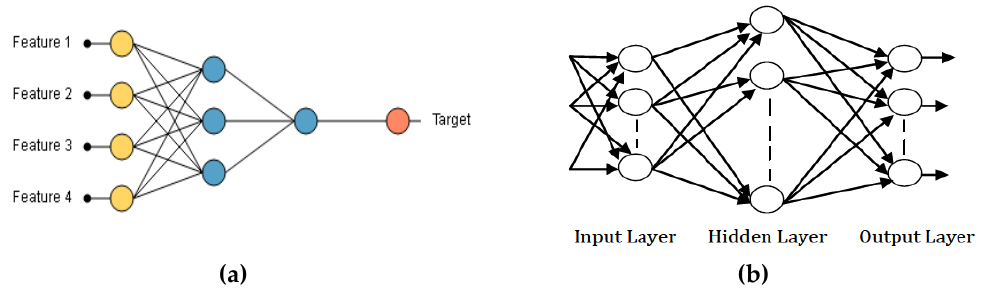
Figure 5. ( a ) Structure of a Neural Network; ( b ) A Three-layered Artificial Neural Network.